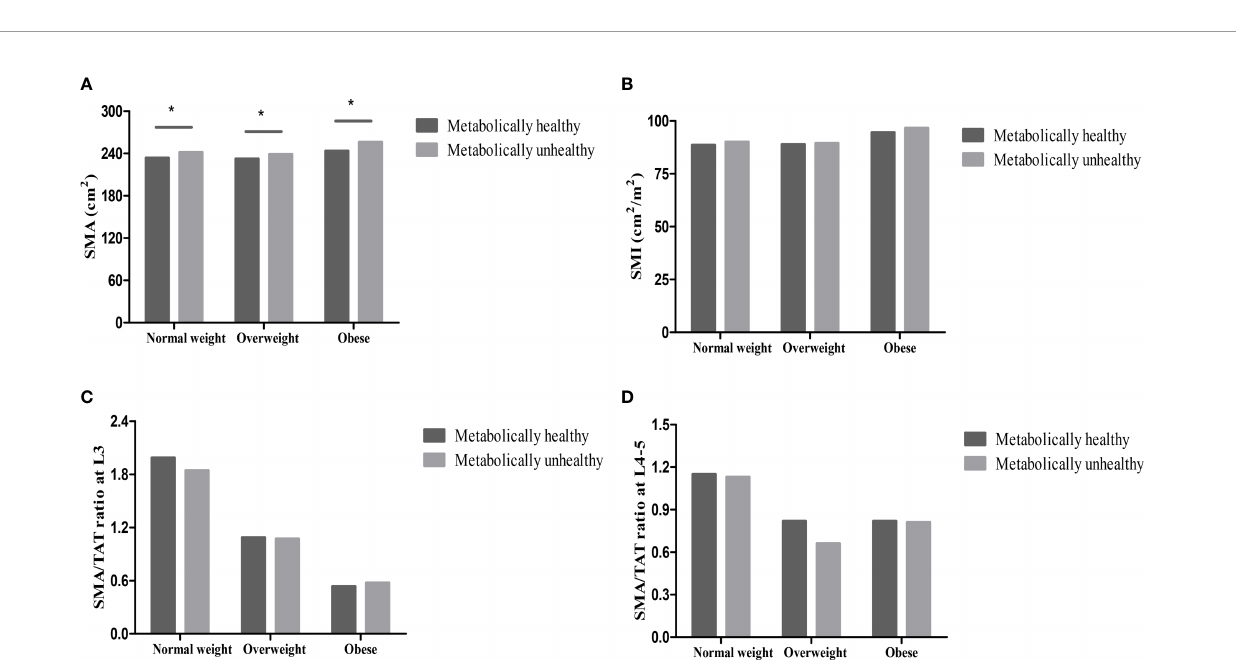
FIGURE 2 | Skeletal muscle in different metabolically phenotypes. (A) SMA in different metabolically phenotypes. (B) SMI in different metabolically phenotypes. (C) SMA/ TAT ratio at L3 in different metabolically phenotypes. (D) SMA/TAT ratio at L4-5 in different metabolically phenotypes. * p